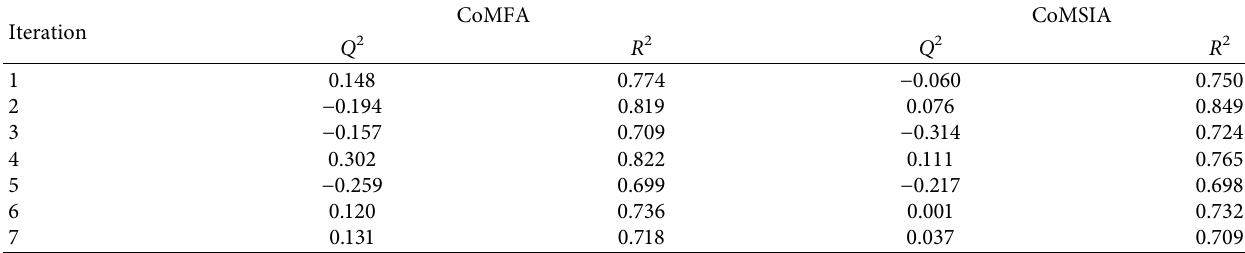
Table 6: Q 2 and R 2 values after several Y-randomization tests.